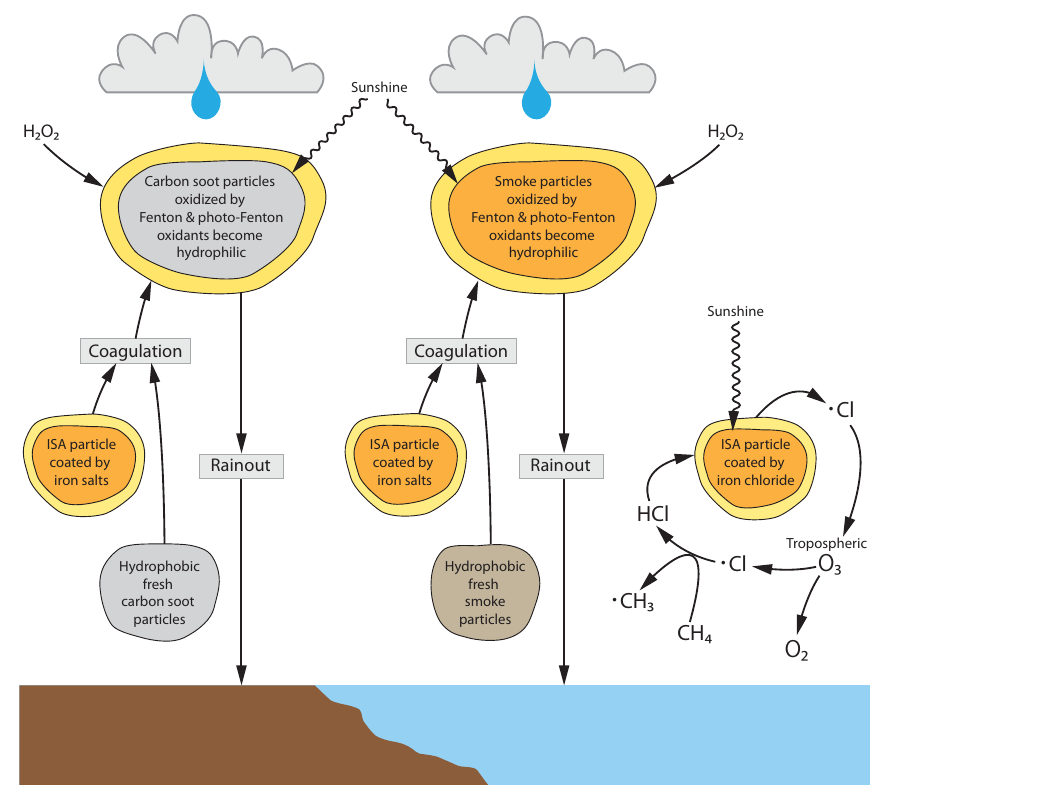
Figure 3. Schematic representation of the cooling of the troposphere by inducing the decrease in ozone and organic aerosol particles such as soot and